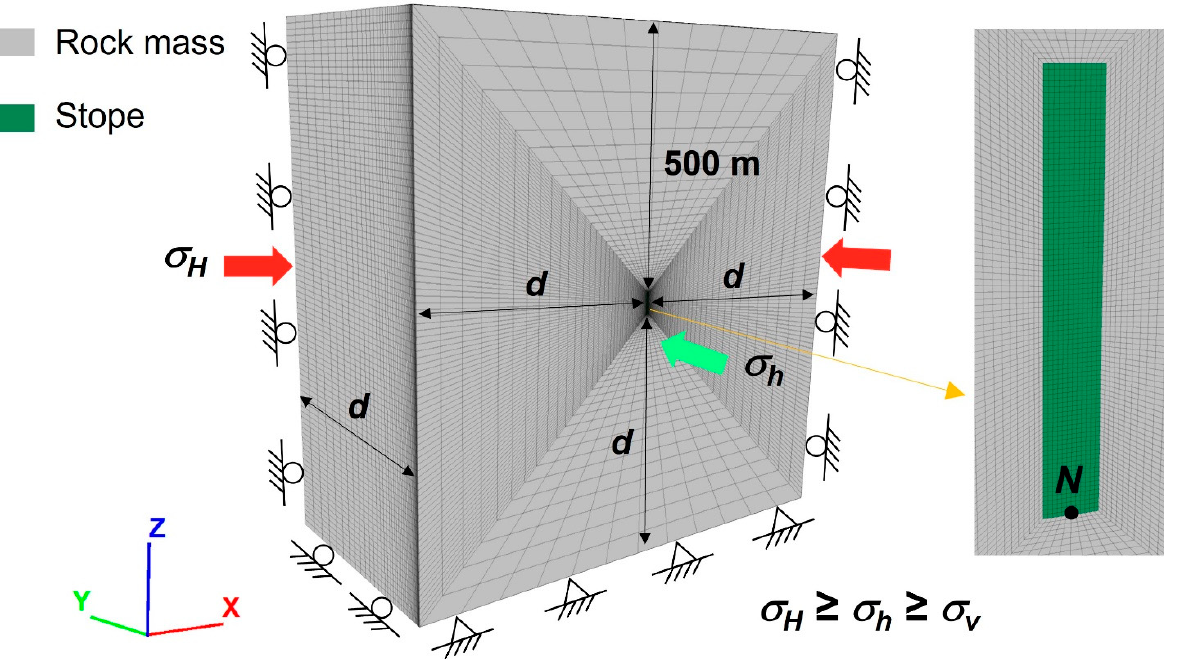
Figure 10. A three ‐ dimensional numerical model of the vertical stope in rock mass built by FLAC3D.